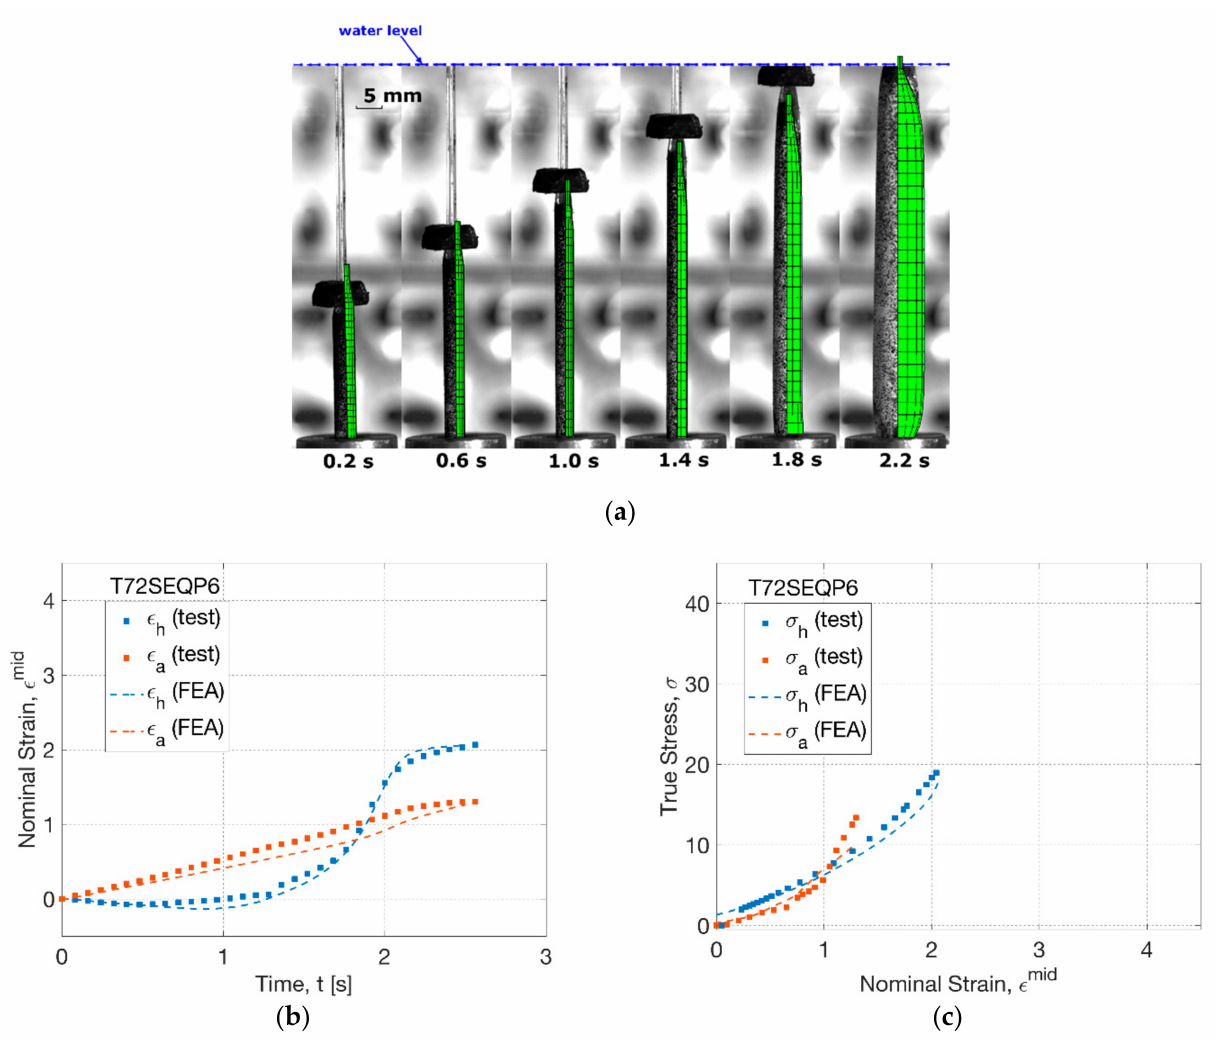
Figure 12. Comparison of results from FEA simulation and blowing test (T72SEQP6): ( a ) shape evolution, ( b ) strain history, ( c ) stress–strain